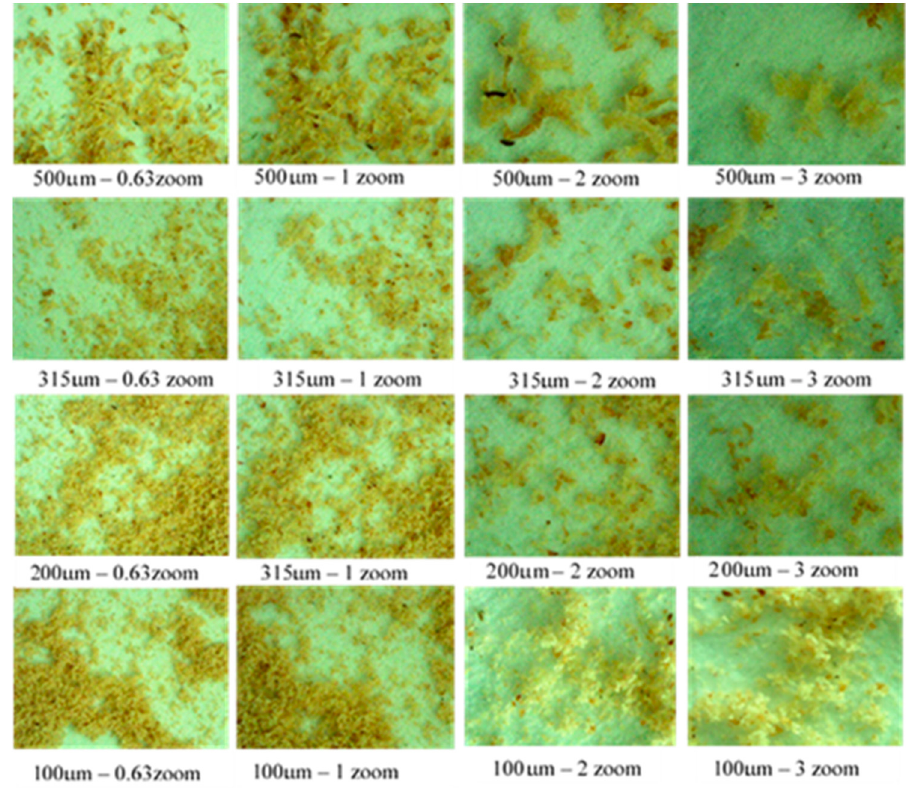
Figure 6. Marblewood dust particles and their shape.